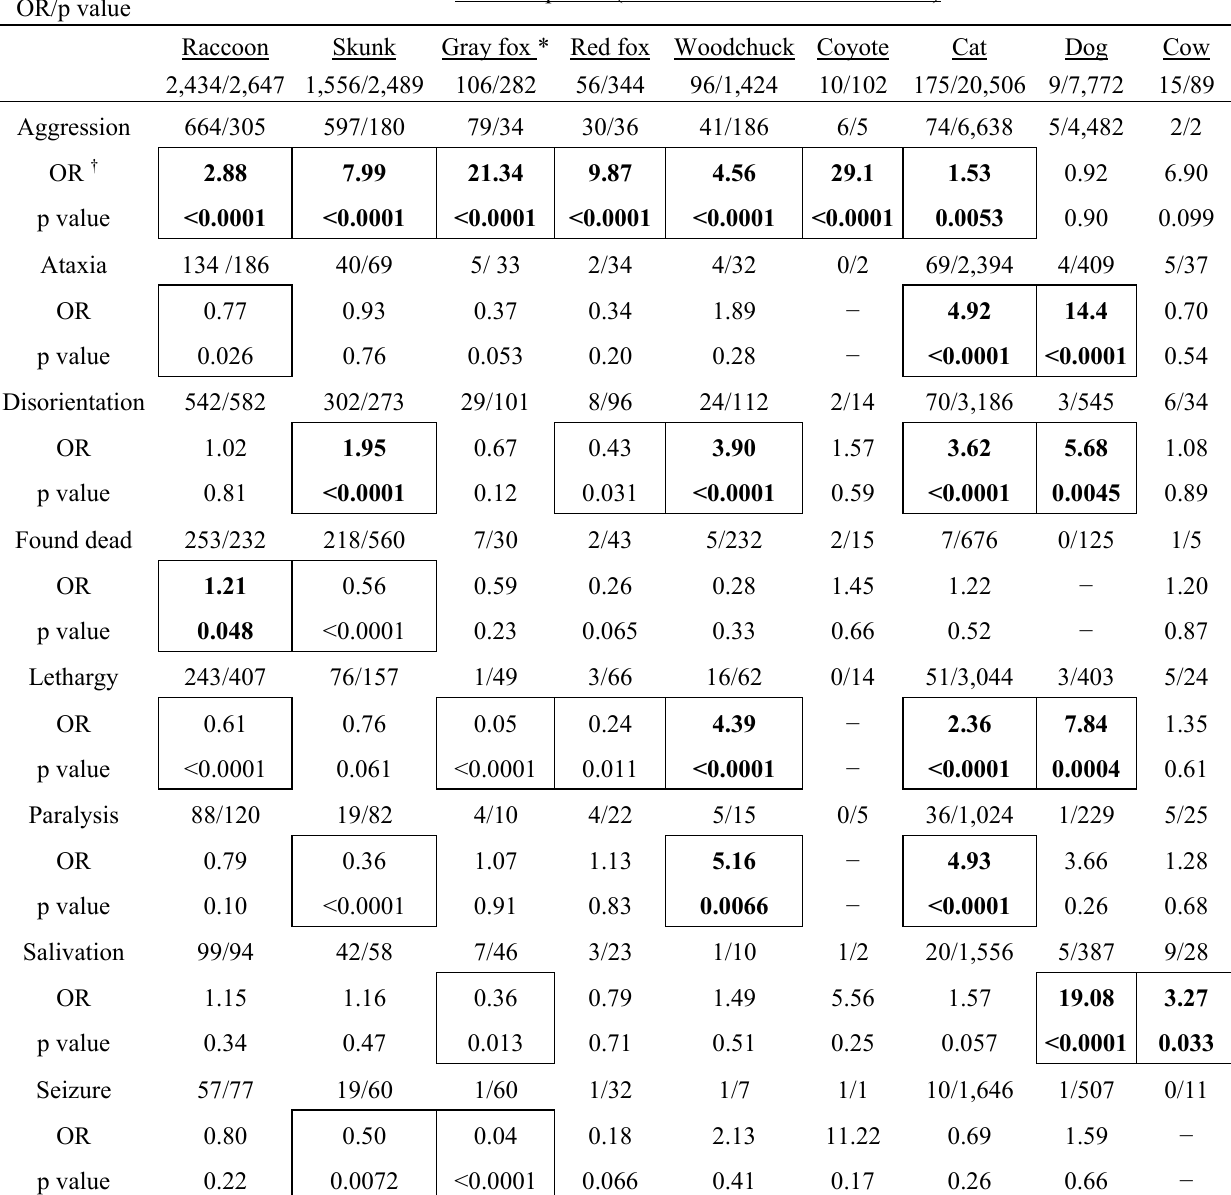
Table1. Reported clinical signs and likelihood of infection by raccoon rabies variant virus, by animal species, Massachusetts, 1992–2010 §